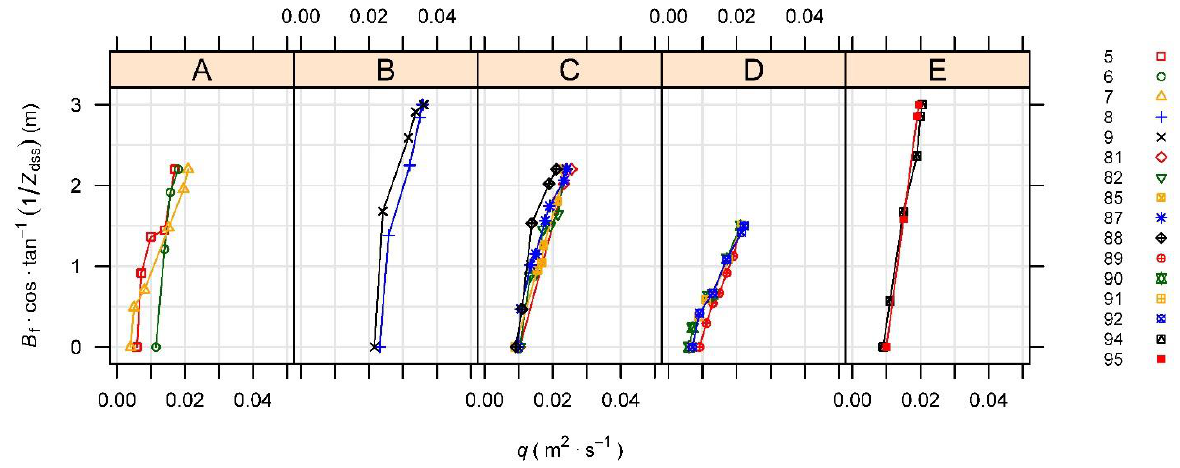
Figure 6. Failure paths obtained with the set of tests performed to assess the variability of the results. Each series represents a physical model with several discharge steps.